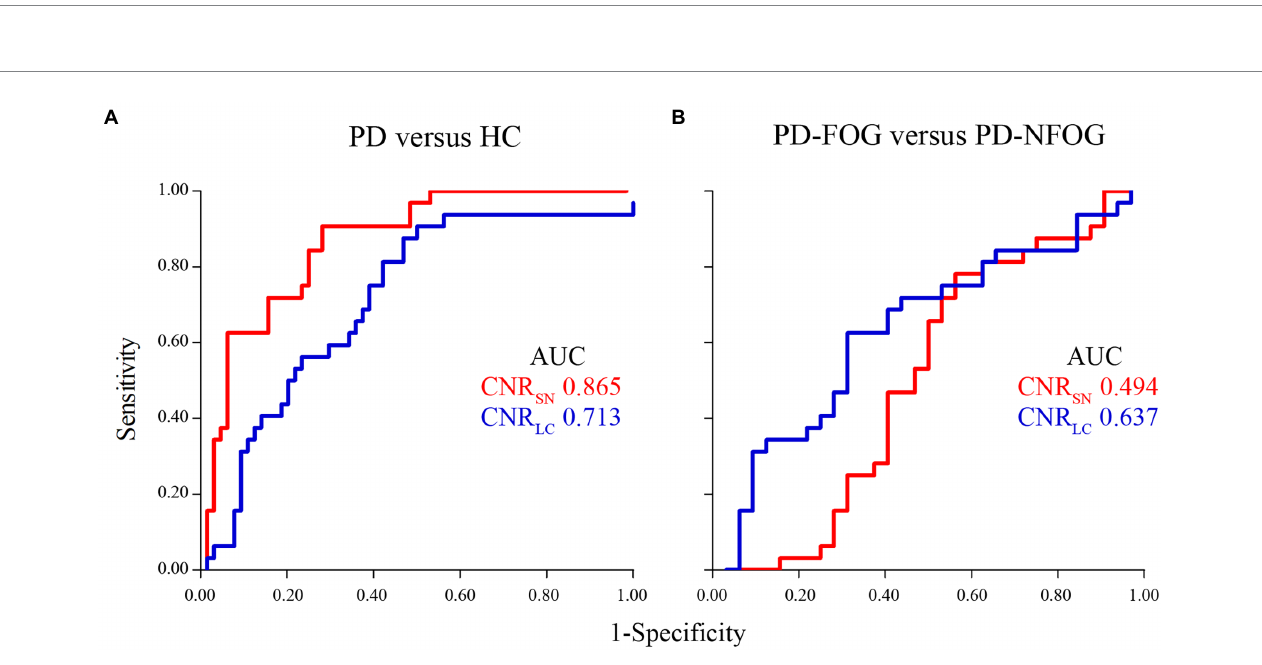
FIGURE 6 ROC analysis of CNR for differentiating between PD patients and HC (A) , between PD-FOG and PD-NFOG (B) . AUC, area under the curve; CNR, contrast to noise ratio; ROC, receiver operating